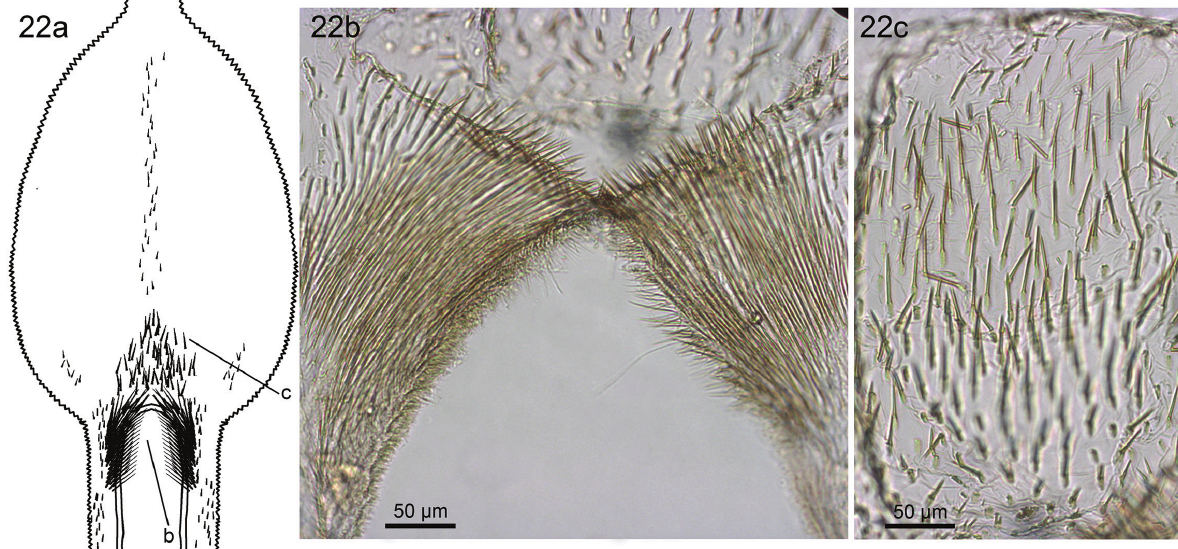
Figure 22. Silvestritermes euamignathus . (a) Schematic drawing of P1 showing arrangement of spines. (b, c) Photomicrographs: (b) Palisade of thin aciculiform spines around the mesenteric tongue; (c) Detail of aciculiform spines just after the mesenteric